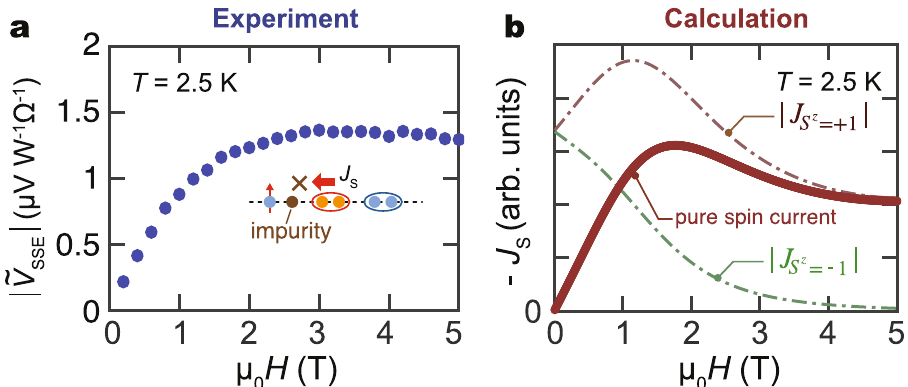
Fig. 4 Magnetic fi eld dependence of SSE voltage. a Magnetic fi eld ( H ) dependence of the magnitude of j ~ V SSE j (absolute value of the SSE signal normalized to the heating power and the detector resistance) at 2.5 K. b Calculation results of the H dependence of the triplon spin current (see text and Supplementary Note G2 for